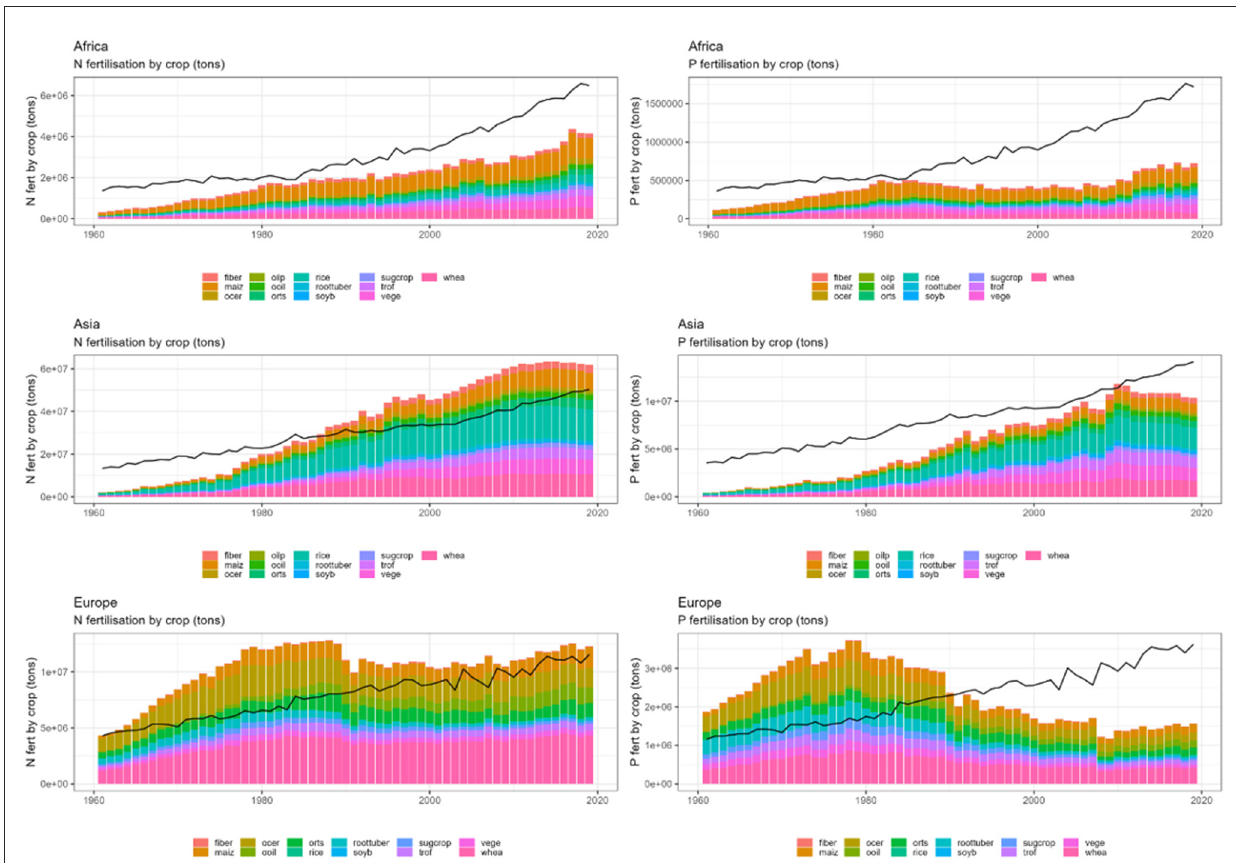
FIGURE6 Long time series of reconstructed nitrogen and phosphorus mineral fertilization by continent and crops. The black line represents the N and P removed by